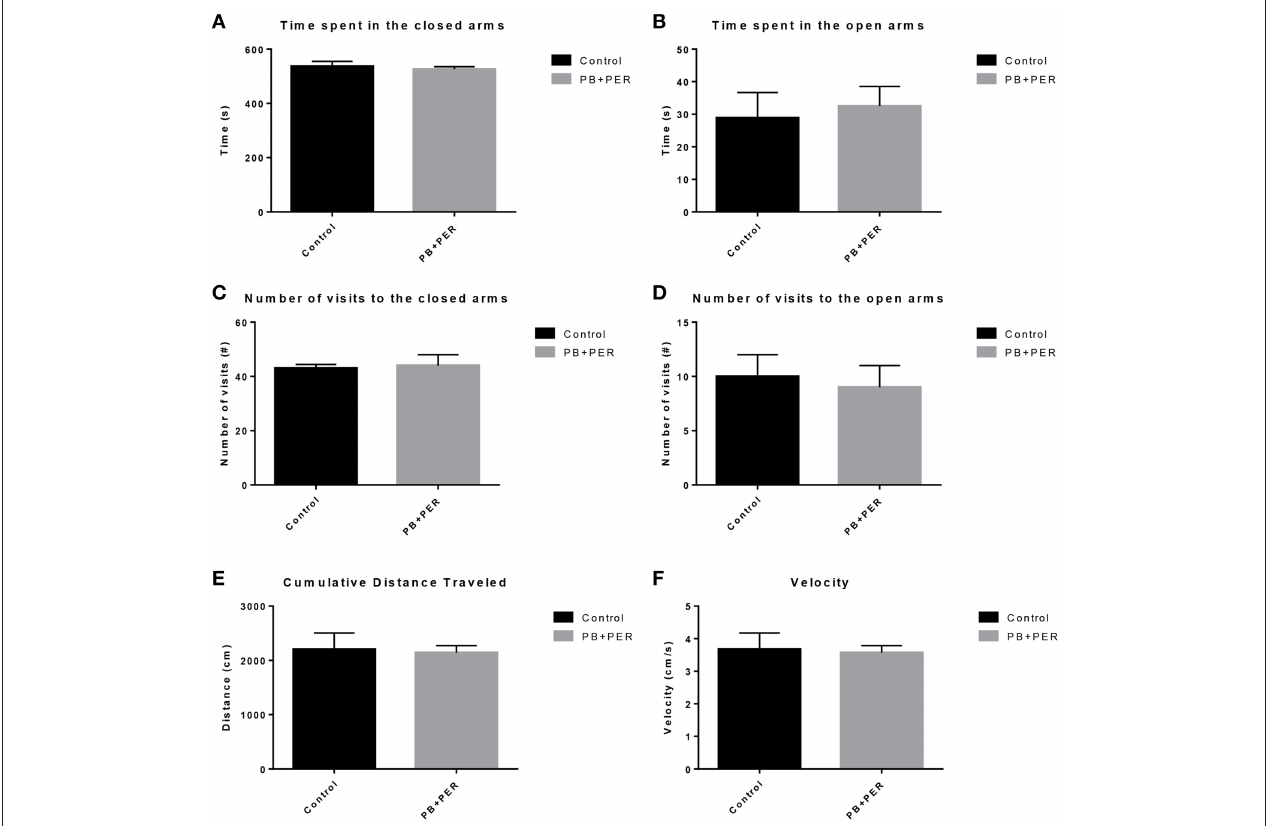
FIGURE 6 | No anxiety-like behaviors were observed in the PB + PER exposed mice, 22.5 months post exposure, as revealed by EPM testing. EPM testing revealed that PB + PER exposed mice spent a similar amount of time in (A) the closed arms, and a similar amount of time in the open arms (B) as compared to their controls. No differences were noted between the two groups when examining (C) number of visits to the closed arms (#) and (D) the number of visits to the open arms. No differences were noted between the two groups when examining (E) cumulative distance traveled (cm) and (F) velocity